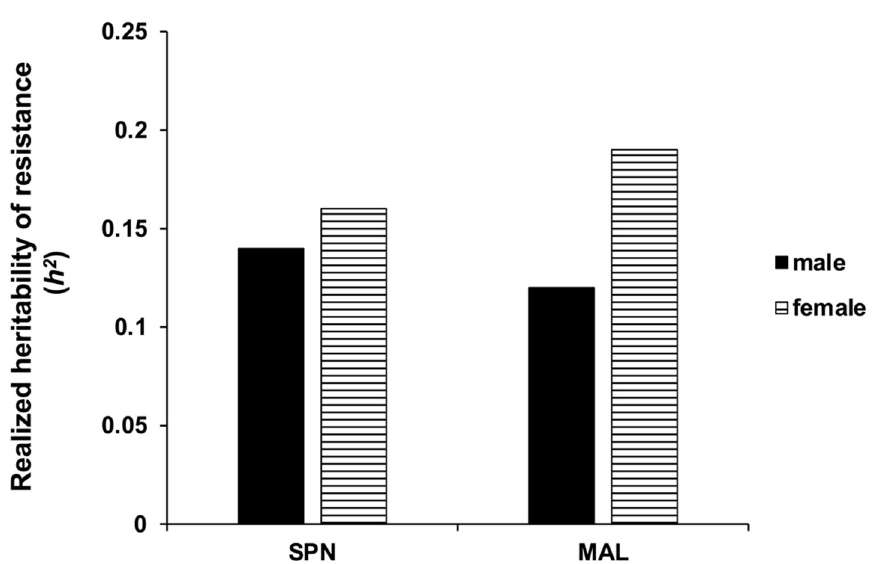
Figure 1. Realized heritability ( h 2 ) of resistance to spinosad and malathion in adult D. suzukii populations selected for resistance in the laboratory.